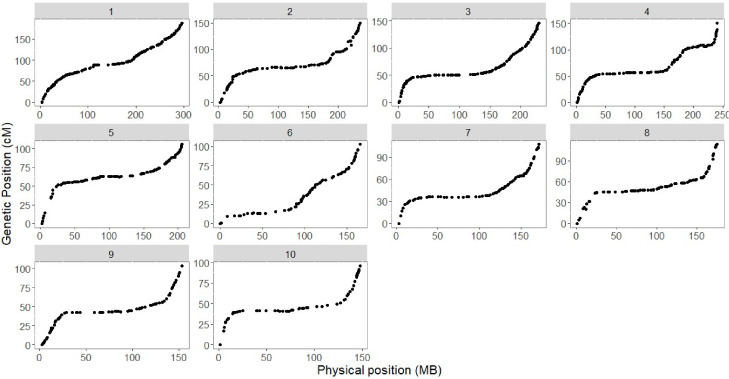
Genotypic analysis.Plot of genetic (y axis) and physical (x axis) position for 1050 genetic markers that compose the genetic map of the CML312 x W22 castor-2 F2 population.